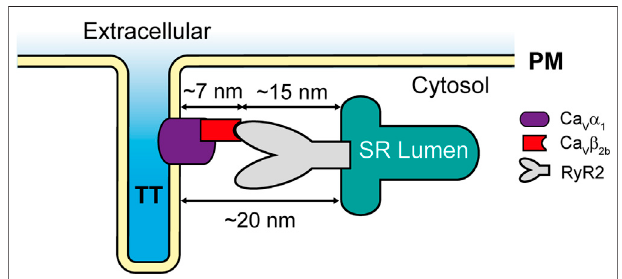
FIGURE 6 | Schematic representation of the LTCC-RyR2 interaction in adult rat cardiomyocytes. PM, plasma membrane; RyR2, ryanodine receptor 2; SR, sarcoplasmic reticulum; TT,